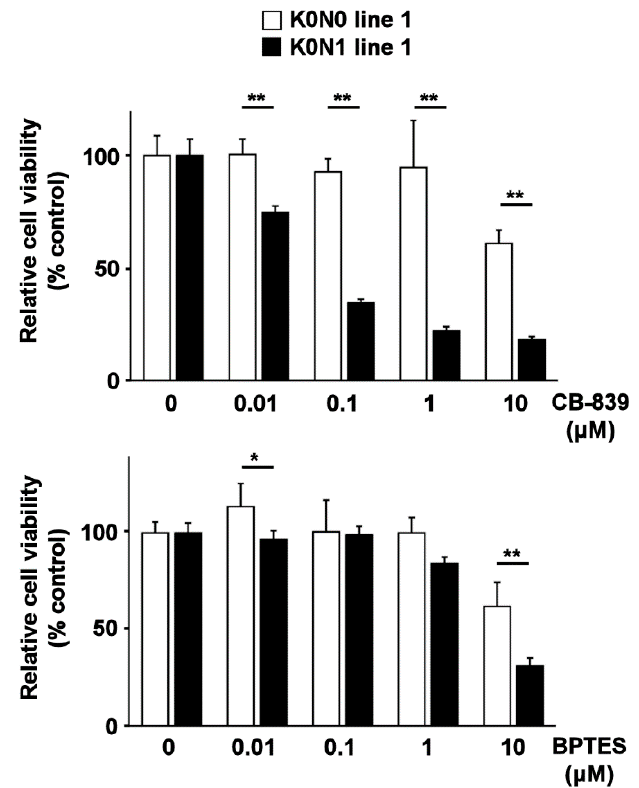
Figure 3. MTT viability assay for K0N1 and K0N0 cell lines after treatment with CB-839 (upper panel) and BPTES (lower panel) ( N = 6, 5000 cells/well, 48 h). * and ** indicate p < 0.05 and p < 0.01 by the Tukey–Kramer method, respectively. The error bars show standard deviations.